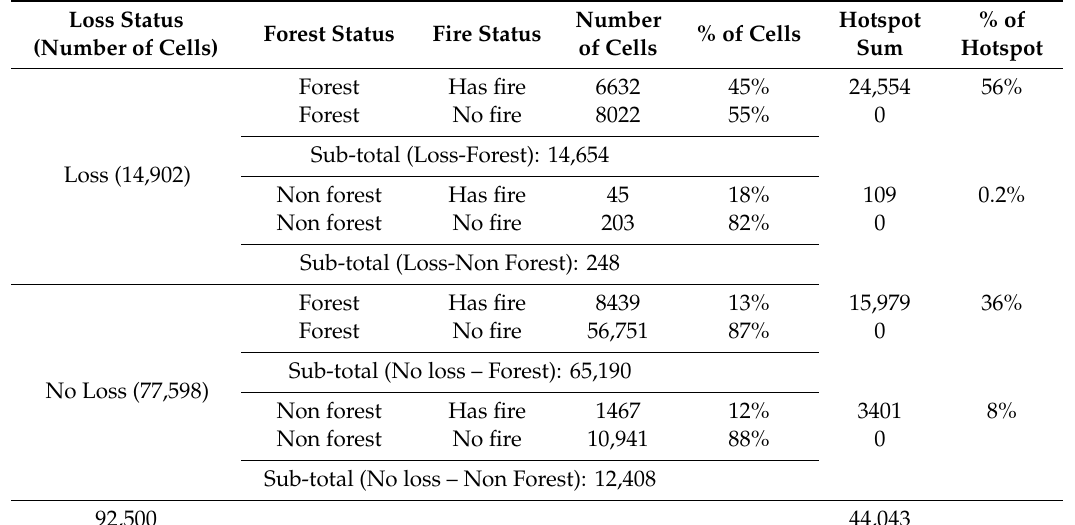
Table 5. Occurrence of hotspots in 1 km 2 cells according to loss, forest cover (2000), and fire status. Cells are categorized as loss if they experienced > 10% forest loss, and as forest if canopy cover in 2000 > 50%.